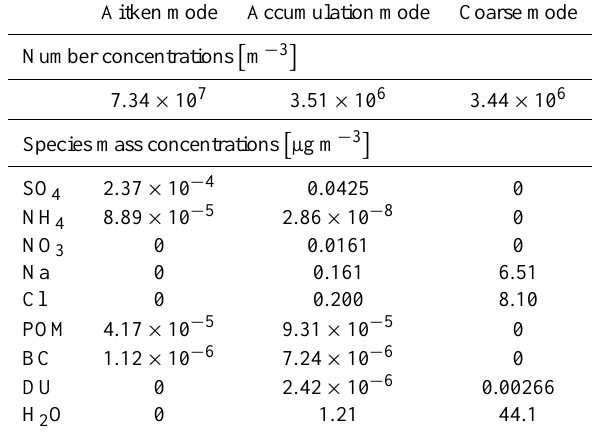
Table 3. Initial number and species mass concentrations in the Aitken, accumulation, and coarse mode size ranges (summed over the respective soluble, mixed, and insoluble modes). Abbreviations are as follows: POM for particulate organic matter, BC for black carbon, and DU for mineral